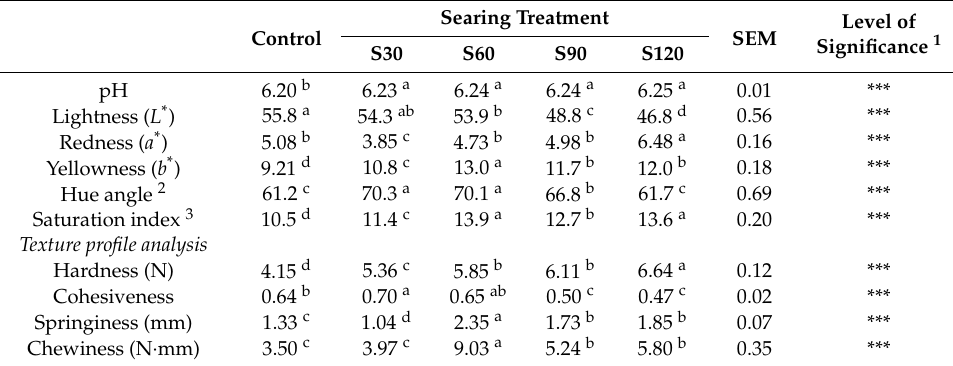
Table 1. E ff ects of searing process on quality characteristics of sous-vide cooked pork patties.